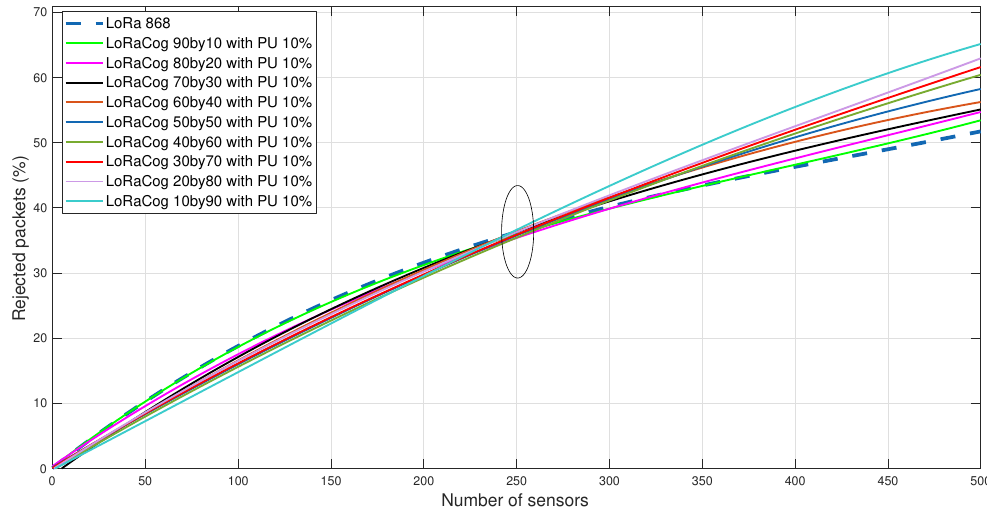
Figure 13. LoRaWAN 868 MHz vs. LoRaCog 868/438 MHz with PU re-appearance probability =